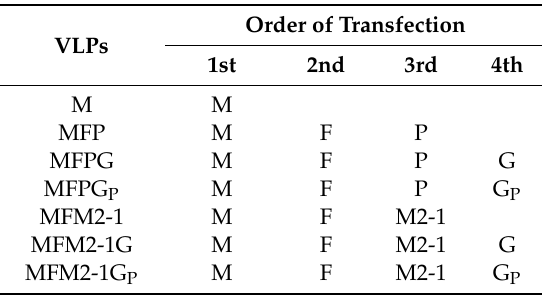
Table 1. Generation of VLPs. 293F / 6TR cells were sequentially and permanently transfected with plasmid DNA coding for RSV proteins as shown in table. G P : G protein peptide (aa 1-86 + 155-206). Order of VLPs